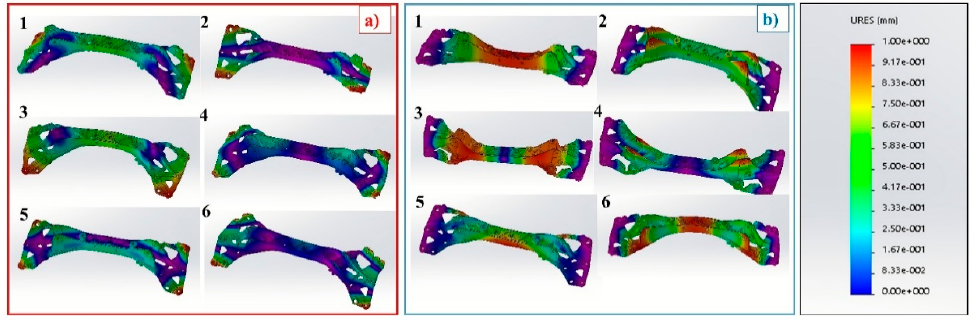
Figure 6. Displacement trend for the first six vibration modes for new geometry: ( a ) free-free boundary conditions and ( b ) fixed conditions. Table 5. Natural frequencies values.